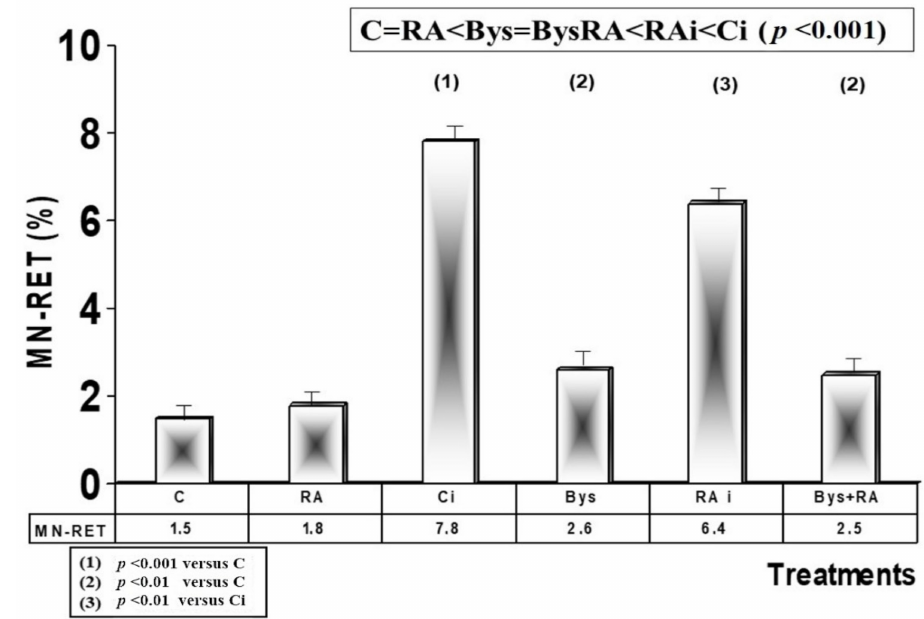
Figure 4. Micronuclei frequency in reticulocytes (C, control; RA, treated with rosmarinic acid; Ci, irradiated control; RAi, irradiated, previously treated with rosmarinic acid; Bys, treated with irradiated serum; Bys + RA, treated with irradiated serum, previously treated with rosmarinic